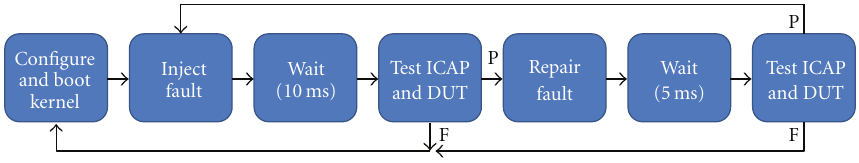
Figure 2: Flowchart of the fault injection